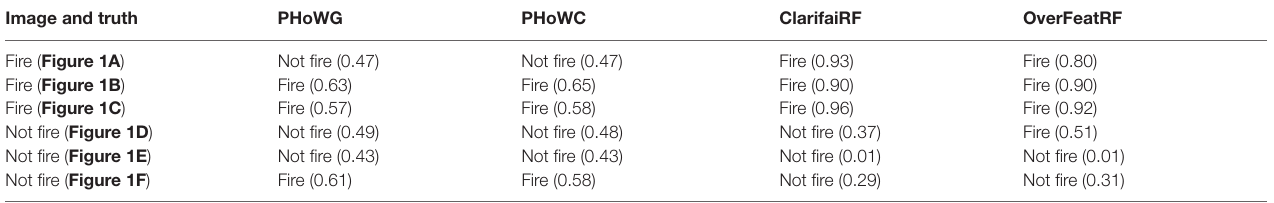
TABle 3 | classification results for the six images shown in Figure 1. Image and truth